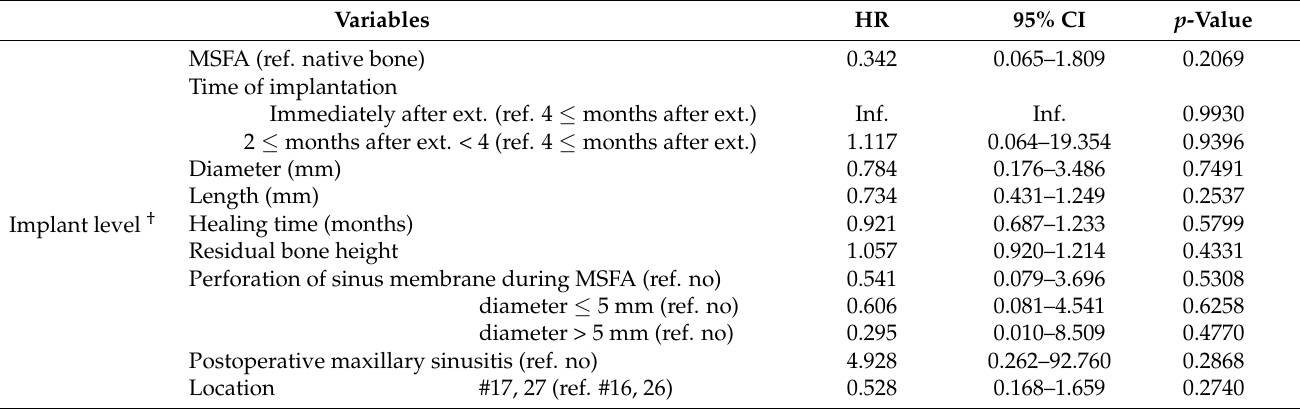
Table 3. Multivariable analysis using a frailty model for implant